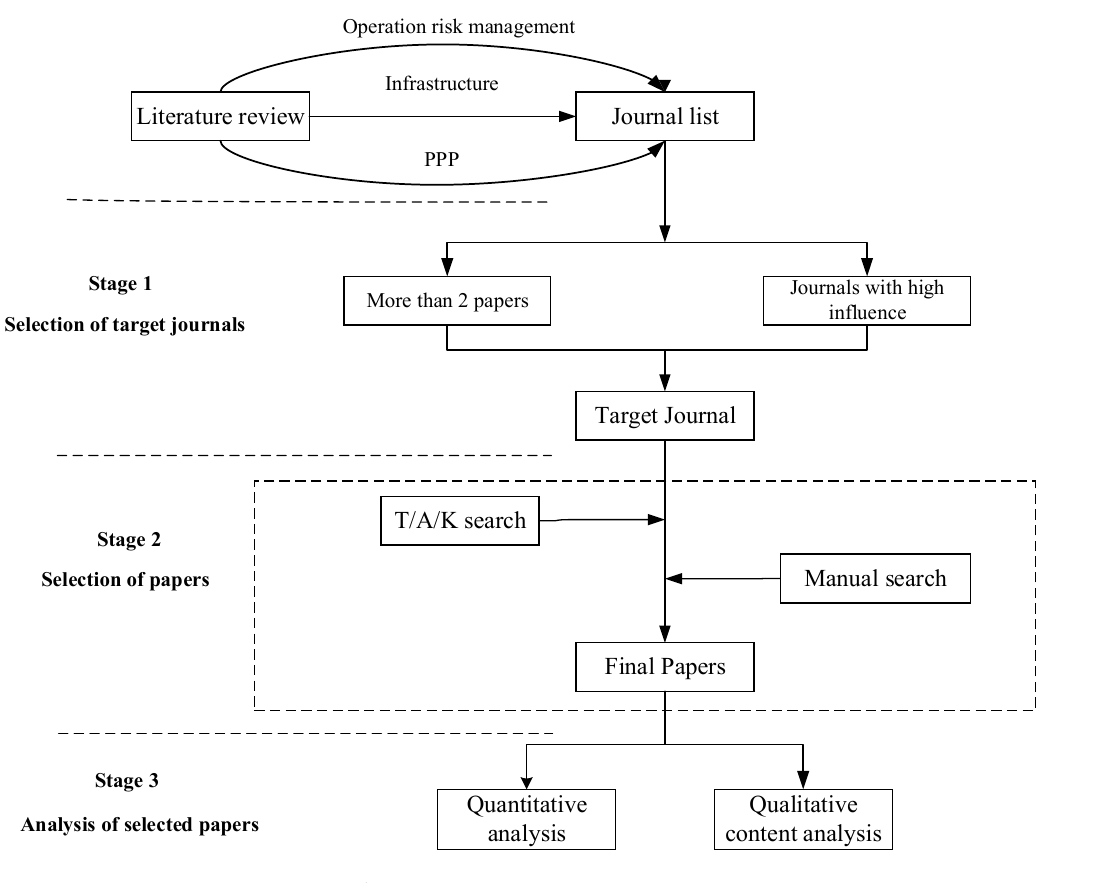
Figure 1. Research route.